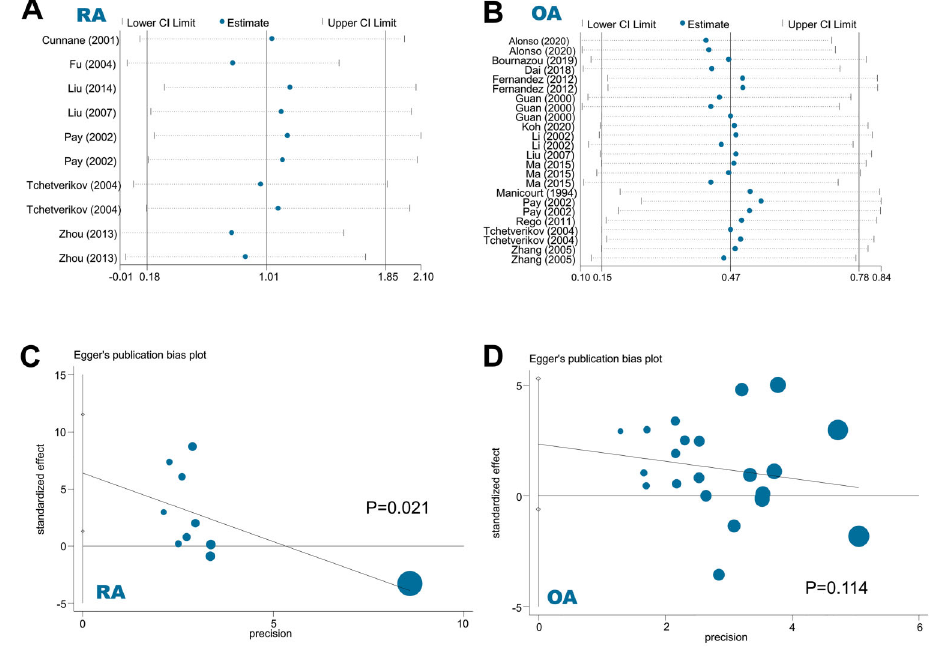
Figure 5. A and B , sensitivity analysis; C and D , Egger ’ s publication bias plot data. RA: rheumatoid arthritis; OA: osteoarthritis. See Supplementary Table S1 for reference